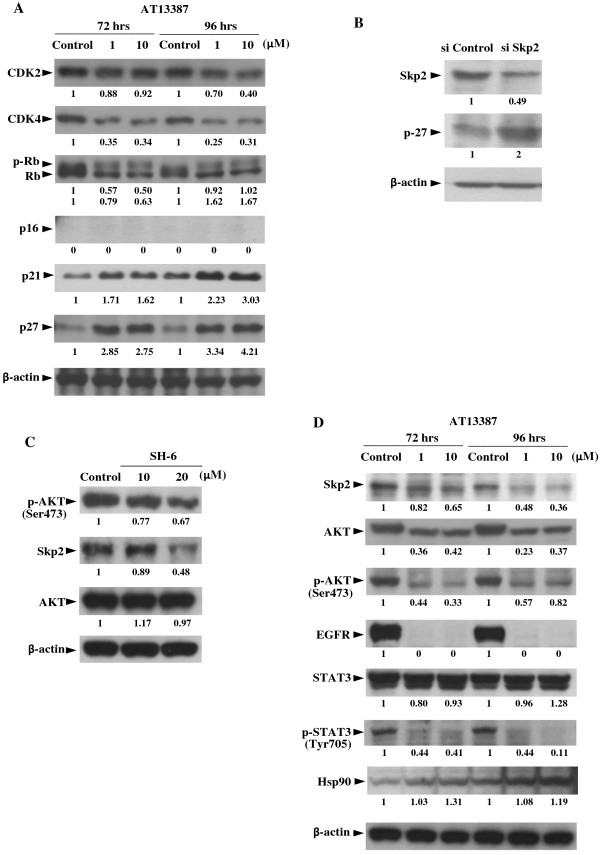
Western-blotting analysis of Hsp90 client proteins and F-box protein S-phase kinase 2 (Skp2) in AT13387-treated C666-1. (A) Expression of senescence and cell cycle associated Hsp90 client proteins in C666-1 after 72 hrs and 96 hrs AT13387 treatment. (B) Knockdown of Skp2 by siRNA leaded to upregulation of p27 in C666-1. (C) Downregulation of p-AKT (Ser473) and Skp2 by AKT inhibitor. (D) Downregulation of Skp2 and Hsp90 client oncoproteins AKT, p-AKT (Ser473), EGFR, and p-STAT3 after AT13387 treatment. Value represented the arbitrary unit of band intensity after normalization with β-actin.